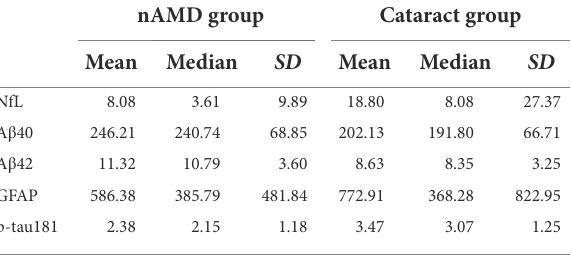
TABLE 1 The levels of AD-related biomarkers in AH in two groups (pg/ml).